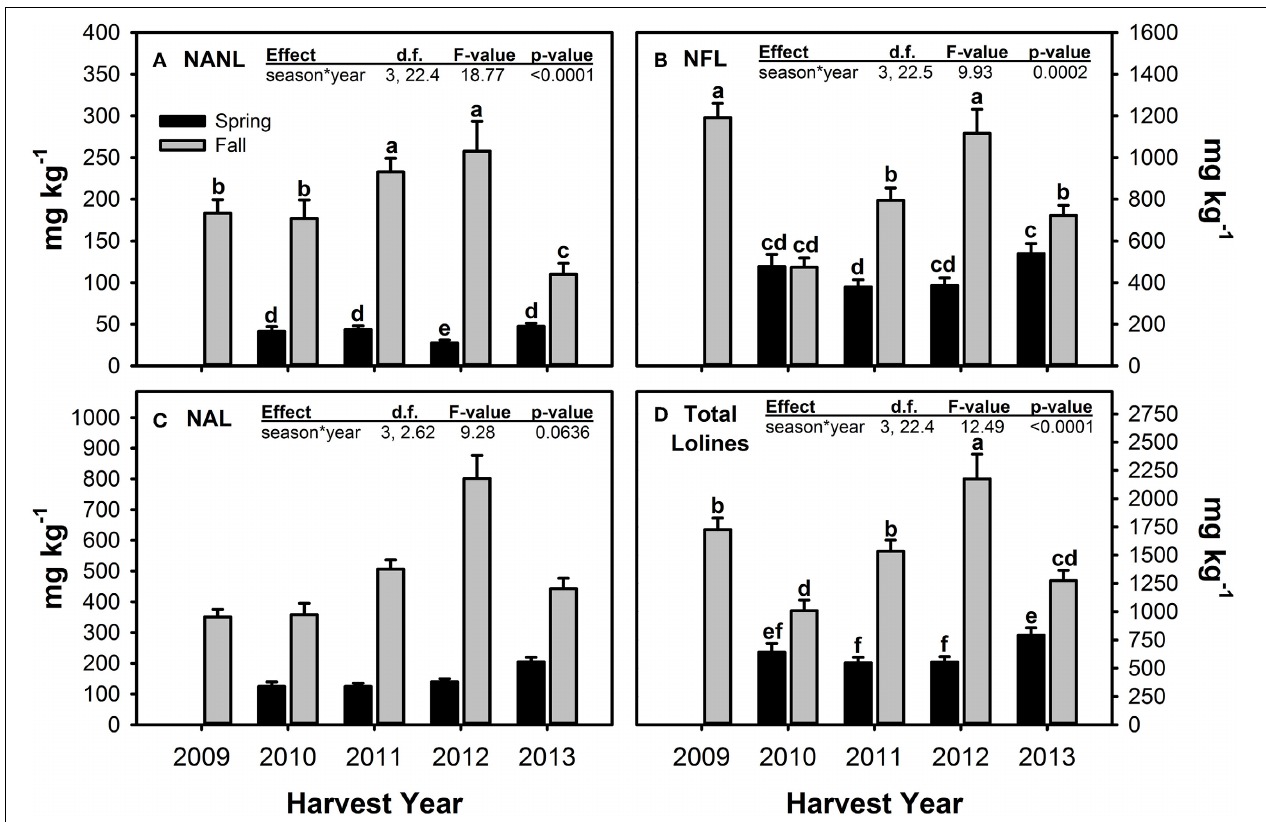
FIGURE 5 | Concentrations of N -acetyl norloline—NANL (A), N -formyl loline—NFL (B), N -acetyl loline—NAL (C), and the sum of these three loline alkaloids (D) measured in endophyte-infected tall fescue tillers harvested in Spring and Fall of all years of the study and averaged ( ± SE)